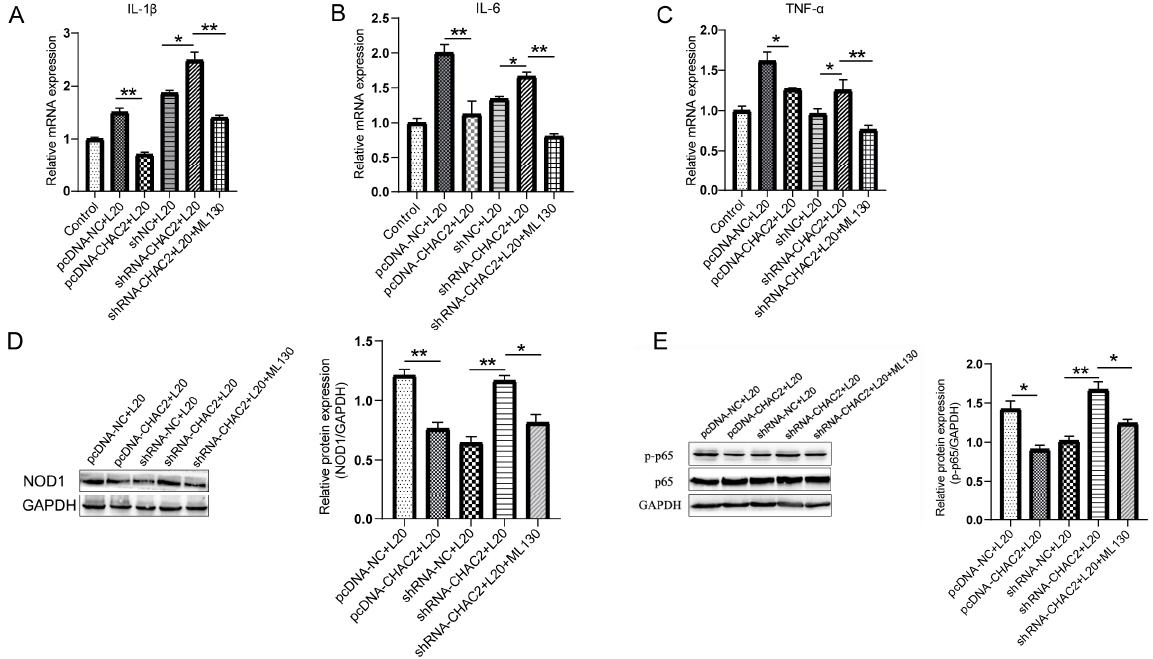
Figure 4. CHAC2 overexpression or suppression altered NOD1/NF- κ B signaling pathway and cytokines expression during A. pleuropneumoniae infection. ( A – C ) mRNA expression levels of the inflammatory cytokines ( A ) IL-1 β , ( B ) IL-6, and ( C ) TNF- α by CHAC2 regulation in A. pleuropneumoniae infection. ( D , E ) The levels of ( D ) NOD1 and ( E ) p-p65 were tested by Western blot analysis. Quantification of Western blot band intensities was performed using ImageJ. One-way ANOVA. * p < 0.05, ** p < 0.01.